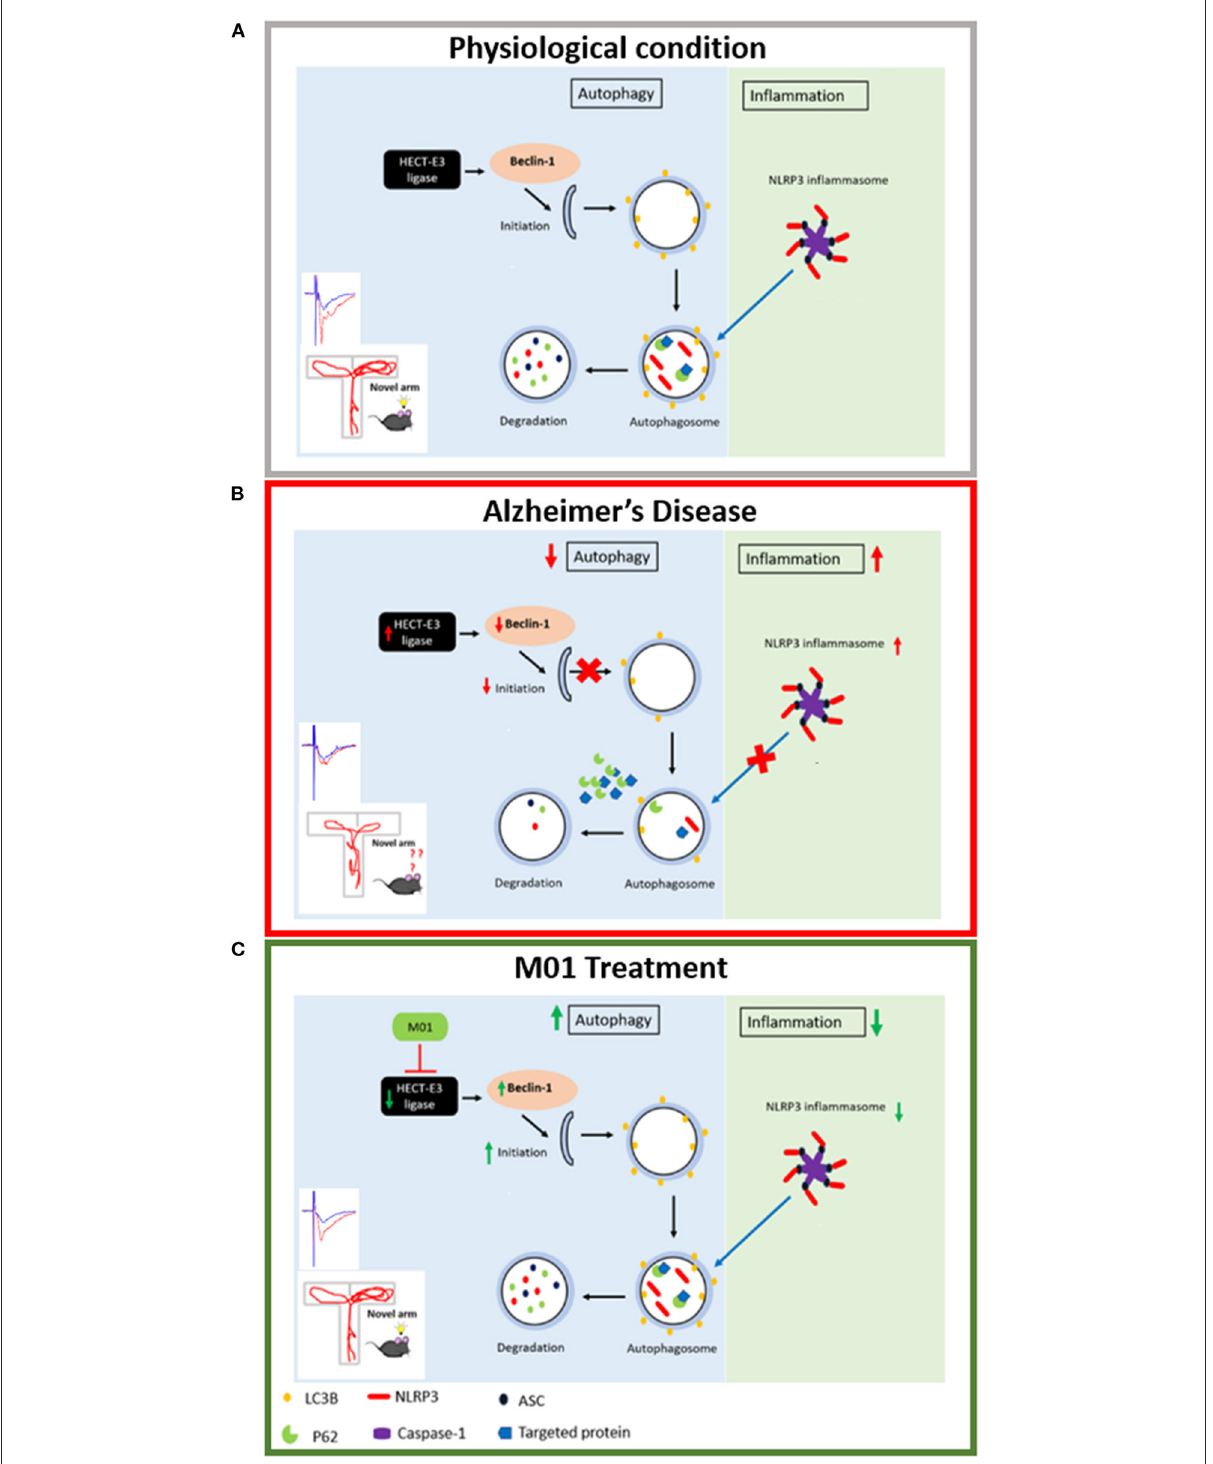
FIGURE8 Schematic representation of the relationship between autophagy process and NLRP3 inflammasome. (A) Physiological condition: Under physiological condition, autophagy and NLRP3 inflammasome pathways are in a homeostatic status. (B) Alzheimer’s disease condition: HECT-E3 ligase downregulates autophagy molecules, in turn, causes dysfunctional autophagy process and increase expression of the NLRP3 inflammasome in AD. (C) M01 treatment: M01 treatment rescued autophagy function and led to the degradation of the NLRP3 inflammasome proteins via